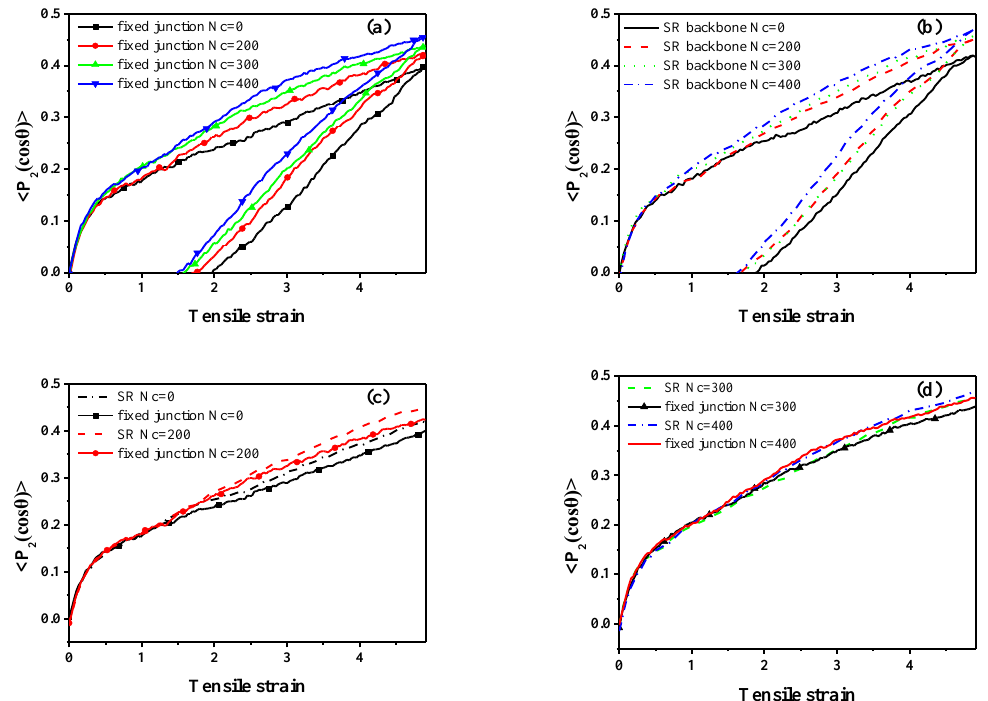
Figure 7. The orientation of the bond, (cid:104) P 2 ( cos θ ) (cid:105) , in backbone during the stretch-recovery deformation in the z direction for different number of cross-linked bonds; Nc within ( a ) the fixed junction systems and ( b ) SR systems; ( c ) comparison of the (cid:104) P 2 ( cos θ ) (cid:105) of backbone in the different system when Nc = 0, 200 during the stretch deformation; ( d ) comparison between the (cid:104) P 2 ( cos θ ) (cid:105) of backbone in the different systems when Nc = 300, 400 during the stretch